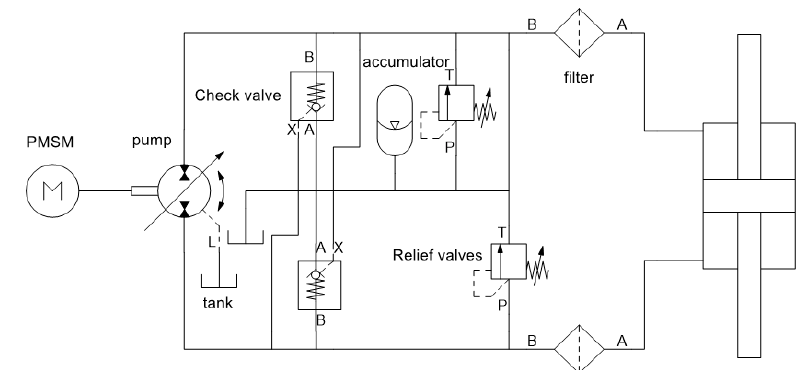
Figure 4. EHA hydraulic circuit diagram.